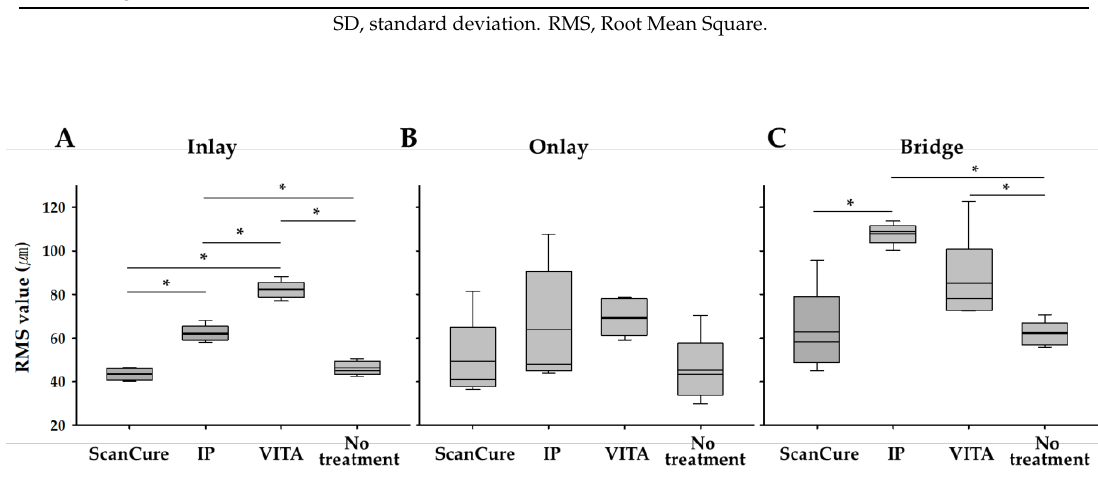
Table 2. Mean trueness value according to an intraoral scanner (mean ± SD of RMS)